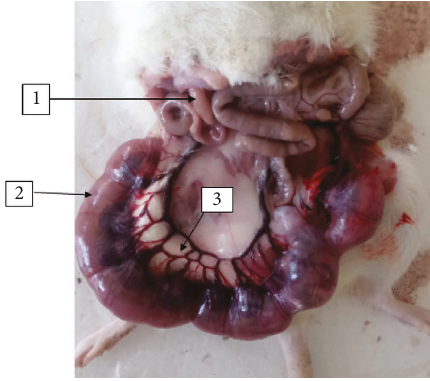
Figure 2: A photograph of rat gravid uterus (1: intestine, 2: gravid uterus, and 3: uterine vessels). Table 6: Pregnancy outcome of rats treated with 80% ethanol fruit extract of Embelia schimperi . Pregnancy outcomes